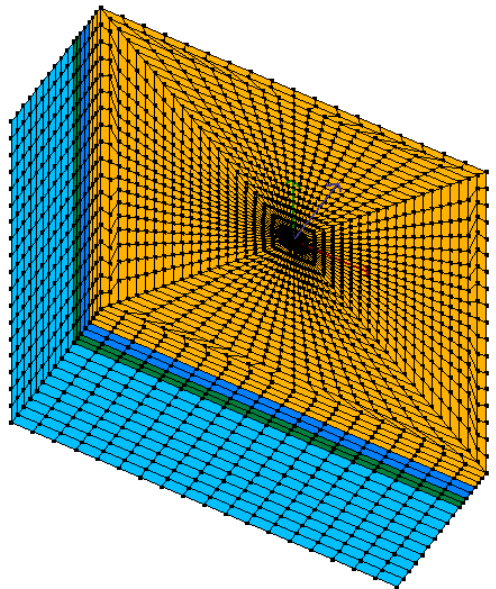
Figure 1. 3D mesh of the soil profile used in the numerical analyses (yellow: S1, blue: S2, green: C, cyan: